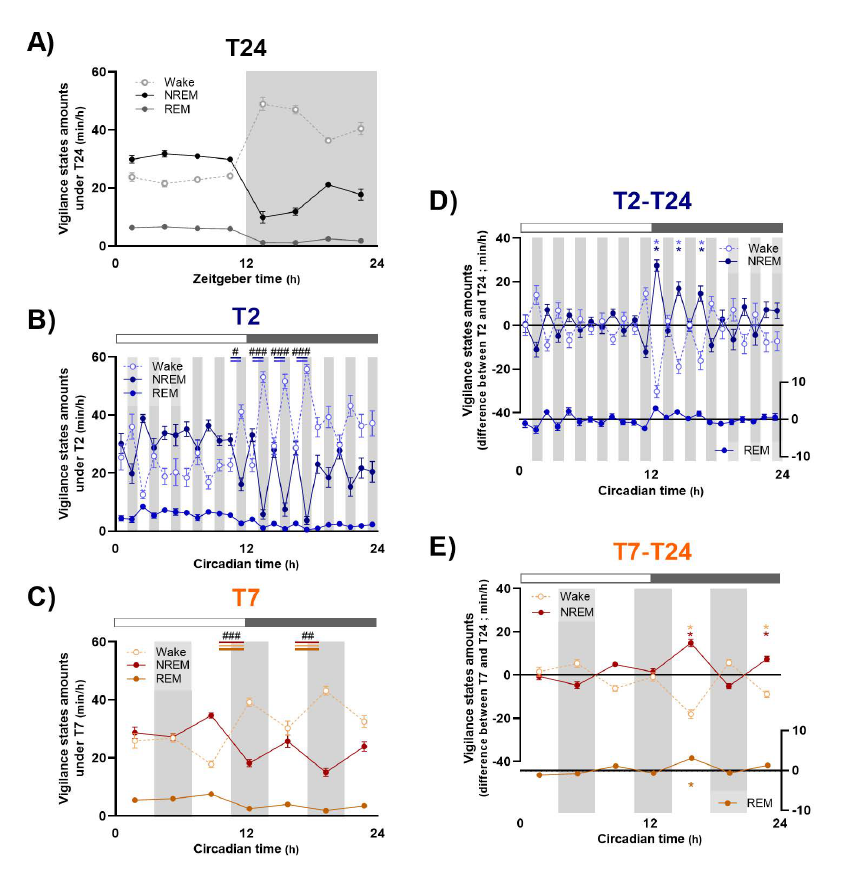
Figure 1. Influence of T2 and T7 ultradian light–dark cycles on wake, NREM and REM sleep distribution. Time course of wake (pale dotted lines), NREM sleep (dark solid lines) and REM sleep (pale solid lines) amounts across T24 (( A ) per 3 h bins), T2 (( B ) per 1 h bins) and T7 (( C ) per 3.5 h bins) LD cycles. Difference of wake, NREM and REM sleep amounts between each light and dark pulse of T2 ( D ) or T7 ( E ) cycles and corresponding time points under T24 cycle. Circles represent means ± SEM. Grey areas delineate dark exposures. #, p < 0.05, ##, p < 0.01, ###, p < 0.001: difference between consecutive light and dark pulses; *, p < 0.05: difference between results obtained under T2/T7 and T24 cycle for specific light pulses. T24: n = 10; T2: n = 9; T7: n =